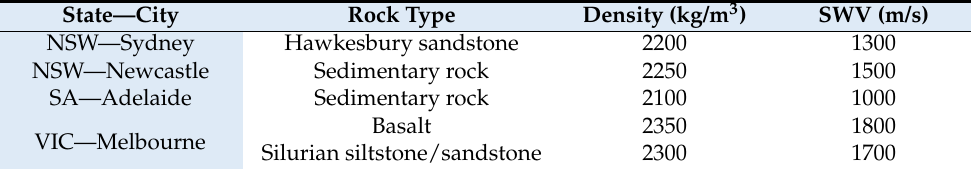
Figure 2. Dynamic properties of soils as per the Hardin and Drnevich model: ( a ) damping curve; ( b ) stiffness reduction curve. Table 5. Recommended bedrock properties for different rock types and